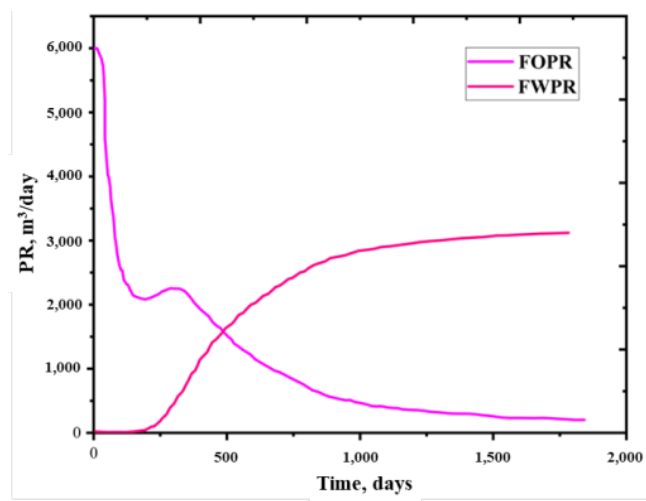
Figure 25. Field water production rate for vertical wells.